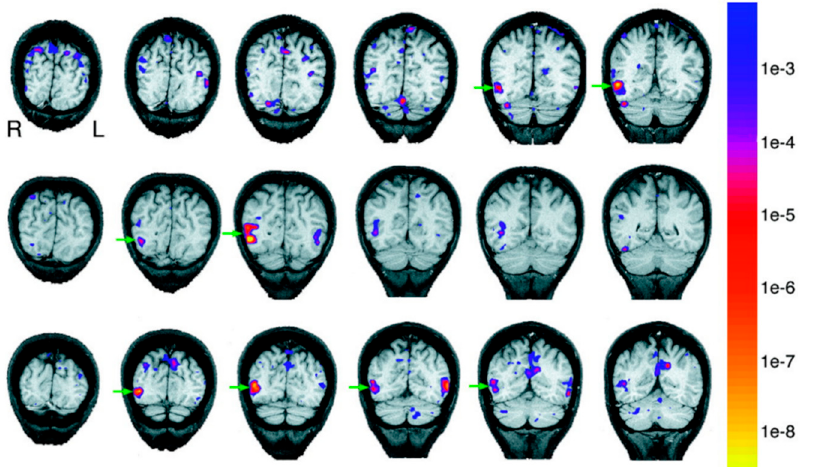
Figure 6. Coronal sections of 3 subjects arranged in separate rows. The anatomical slices are overlaid with statistical maps of voxels with selective response for human bodies and body parts. Adapted with permission from Downing et al. (2001). The green arrow indicates the region with maximal response. The color scale on the right stands for the p values of the activations.